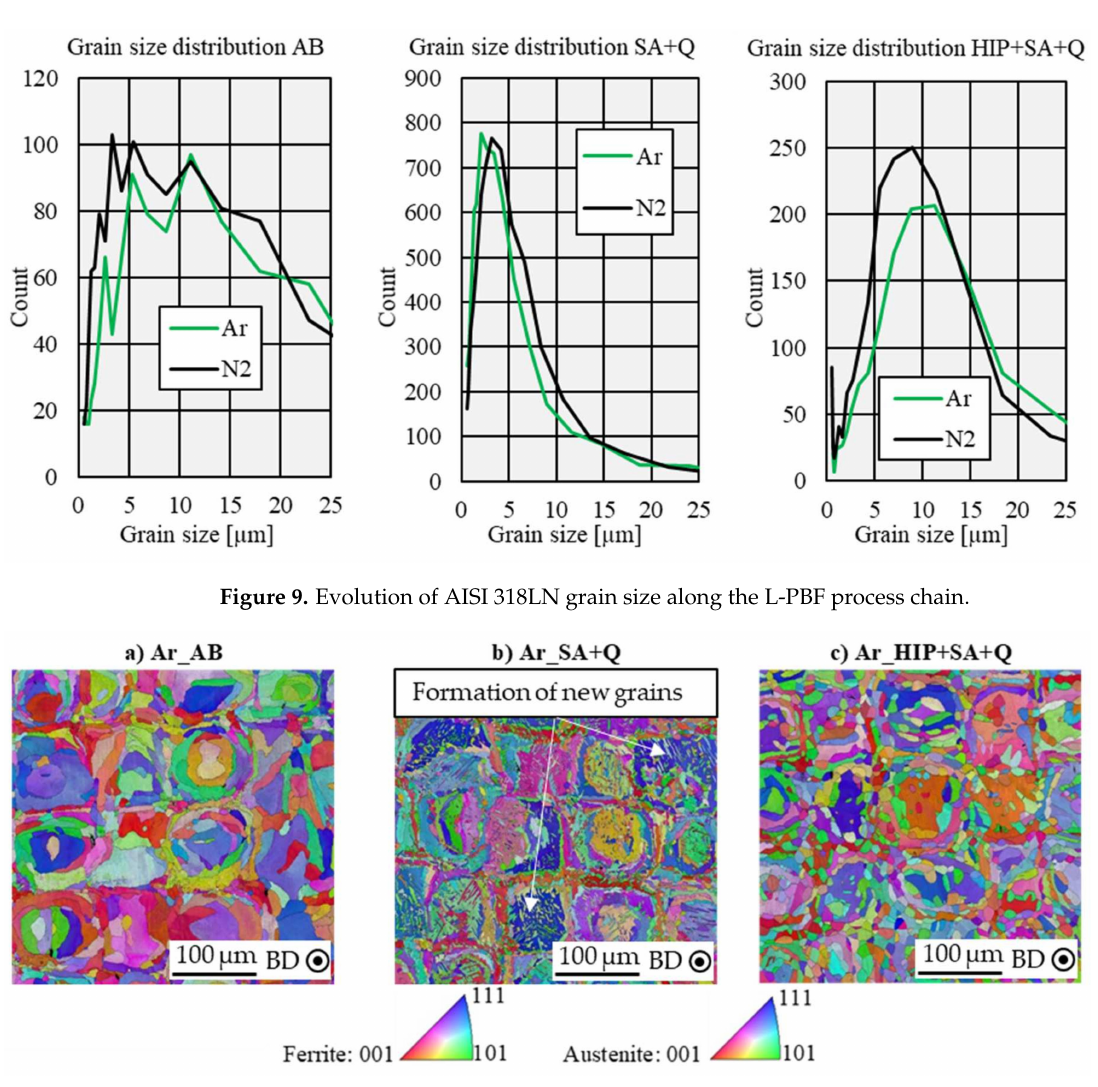
Figure 10. IPF maps of L-PBF AISI 318LN processed under an argon protective atmosphere: ( a ) AB condition, ( b ) SA + Q condition, ( c ) HIP + SA + Q condition. BD: building direction.